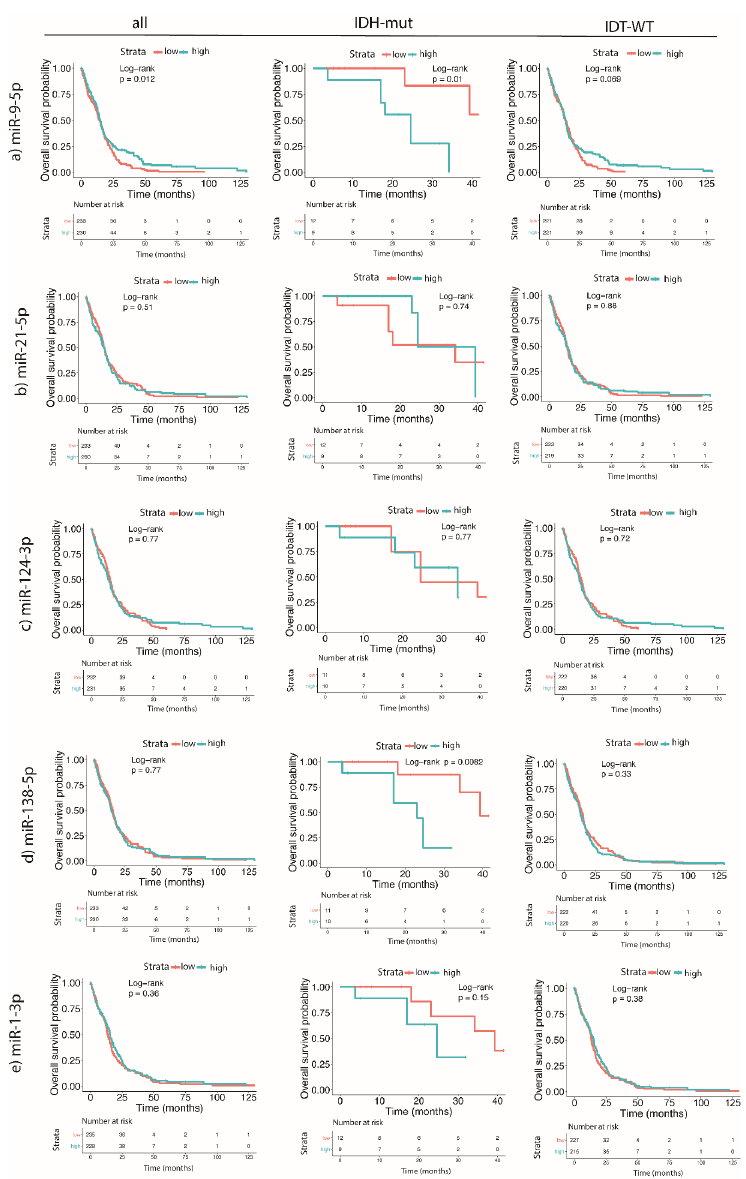
Figure 3. Survival analysis in GBM patients based on the expression levels of miRNAs (miR-9-5p, miR-21-5p, miR-124-3p, miR-138-5p, and miR-1-3p) and IDH mutation status in GBM tumor tissues. ( a )